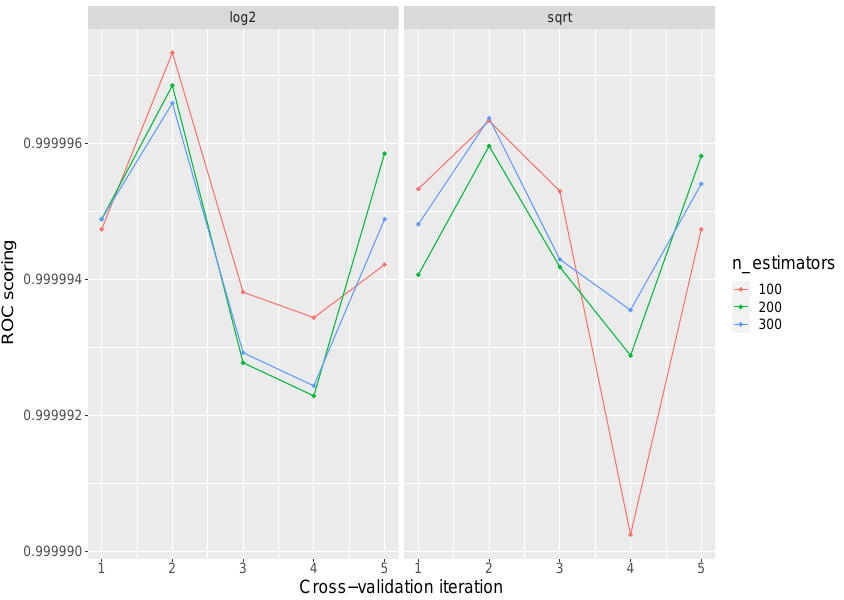
Figure 4. Random Forest mean scoring by iteration.